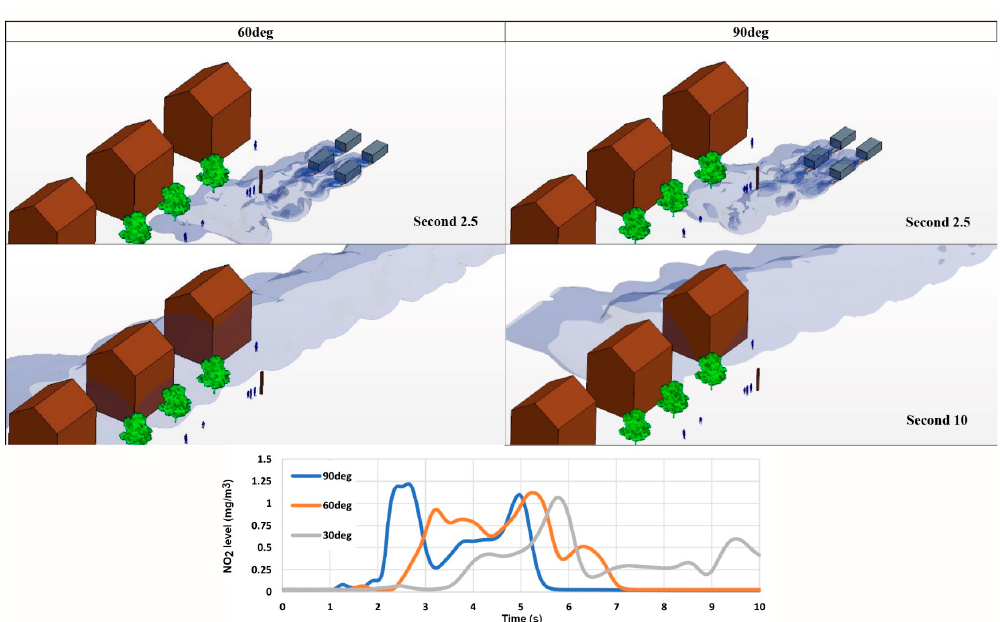
Figure 4. NO 2 concentrations for the teenager pedestrian standing by the traffic light, from 60 deg and 90 deg wind direction.